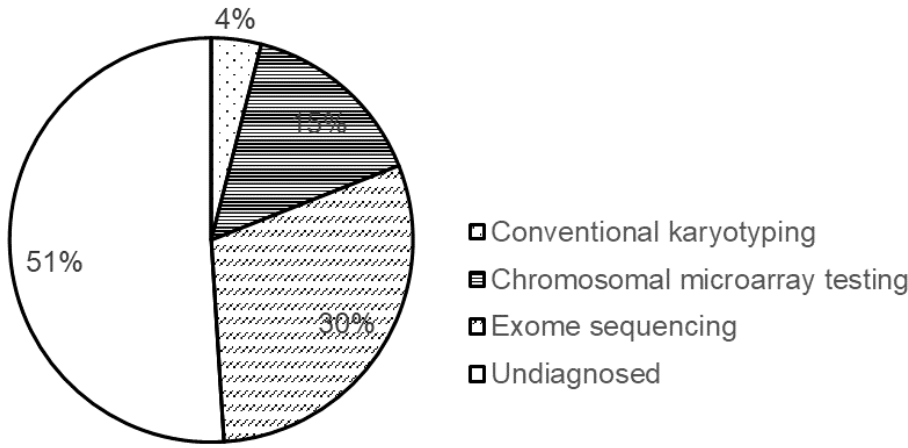
Figure 3. Schematic representation of diagnostic yields of various methods used for genetic testing. Diagnostic yields of the methods are shown in % plot format.